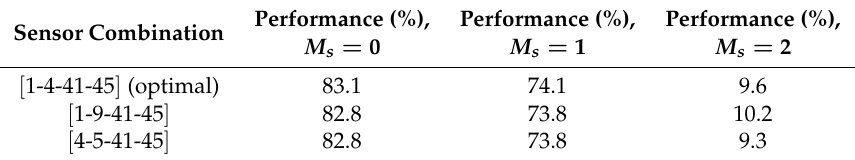
Table 3. Comparison of the best four-sensor combinations for the panel depicted in Figure 7. Sensor